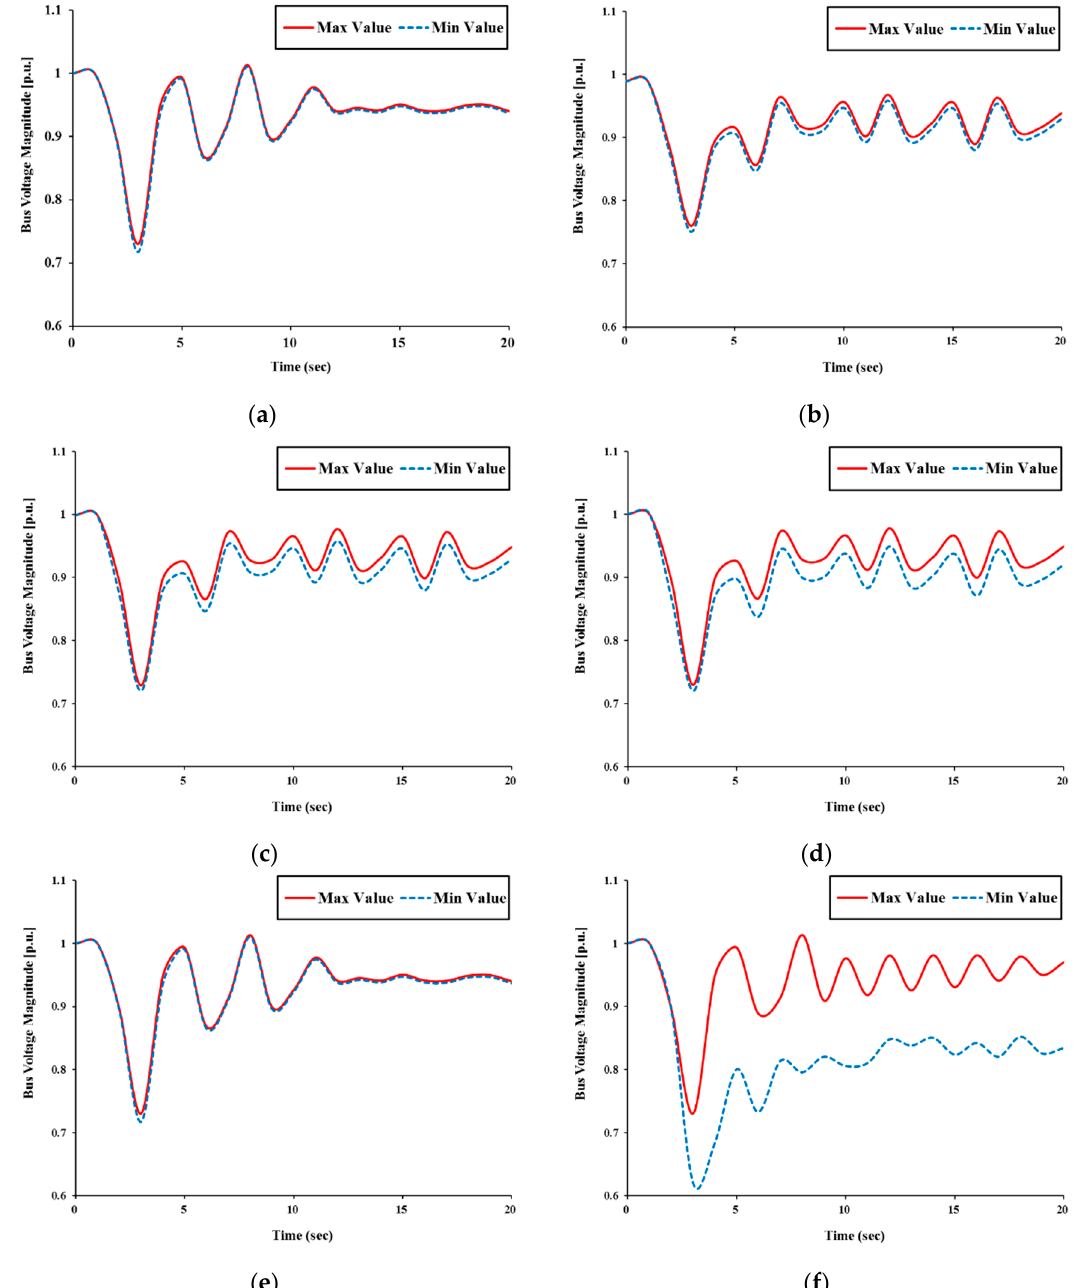
Figure 5. Bus voltage sensitivity analysis results of IM parameters. ( a ) R s ; ( b ) X s ; ( c ) R r ; ( d ) X r ; ( e ) X m ; ( f ) H